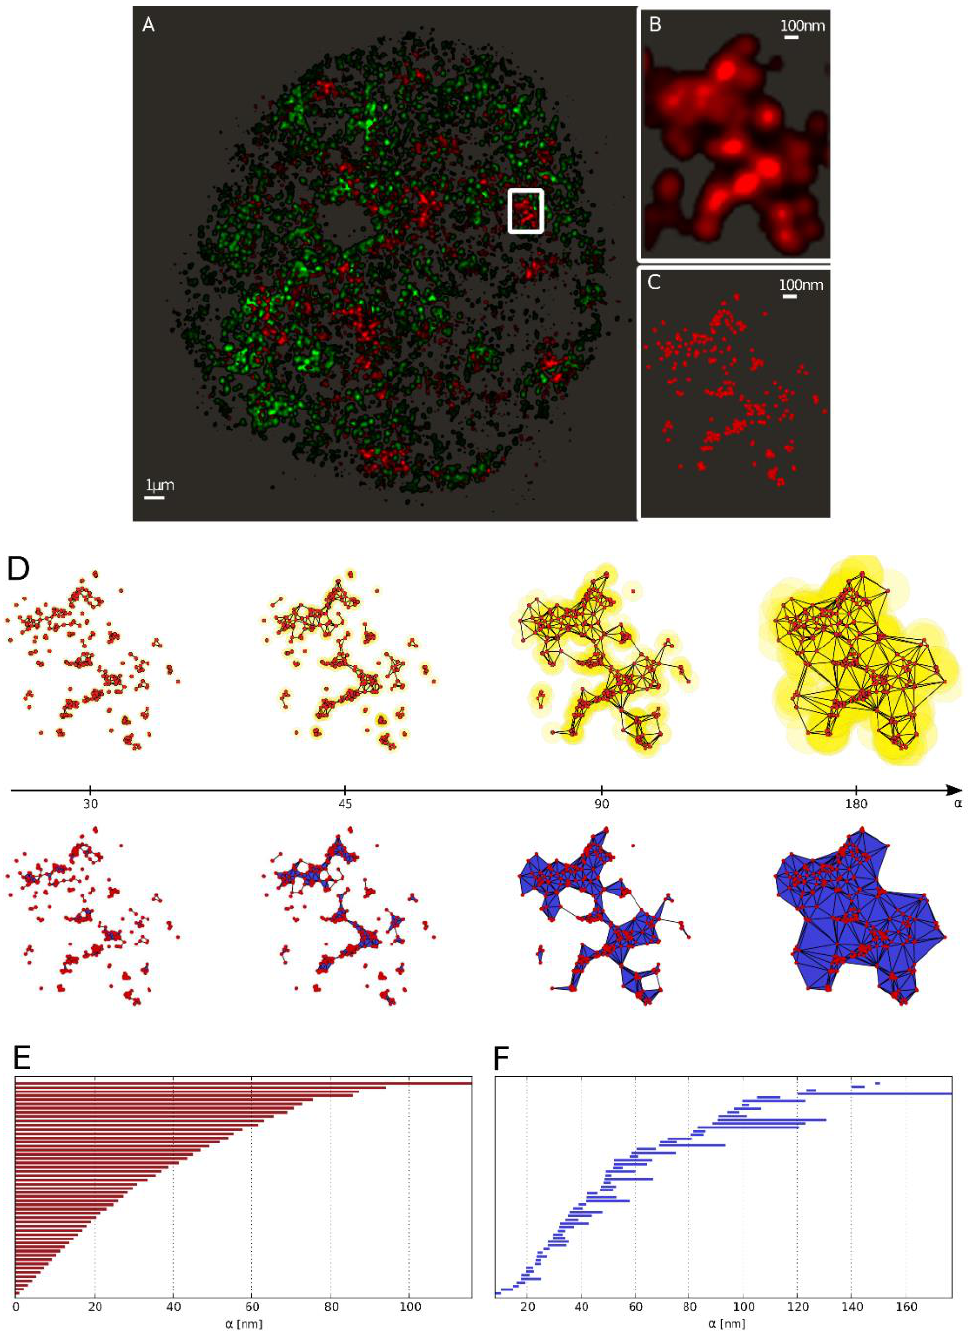
Figure 3. From the single molecule localization microscopy (SMLM) data to the barcode representation. ( A ) Full view of heterochromatin (green; labeled by antibodies against H3K9me3) and γ H2AX labeling (red) of a SkBr3 cell nucleus 30 min after irradiation with 2 Gy depicted as a density image. ( B ) Zoom-in into the marked γ H2AX cluster. ( C ) Scatter plot of the marked γ H2AX cluster (every point represents a detected fluorophore). ( D ) Components of the α -shape filtration of the marked γ H2AX cluster exemplarily depicted at α = {30, 45, 90, 180} nm (left to right). As the growing spheres mutually embed the center of each-other the corresponding centers are connected by an edge (as shown in the upper row). Whenever a triangle is formed, it is included in the solid as a face element (illustrated in the lower row). ( E ) Barcodes of dimension 0 (Betti number) corresponding to connected components. ( F ) Barcodes of dimension 1 (Betti number) corresponding to